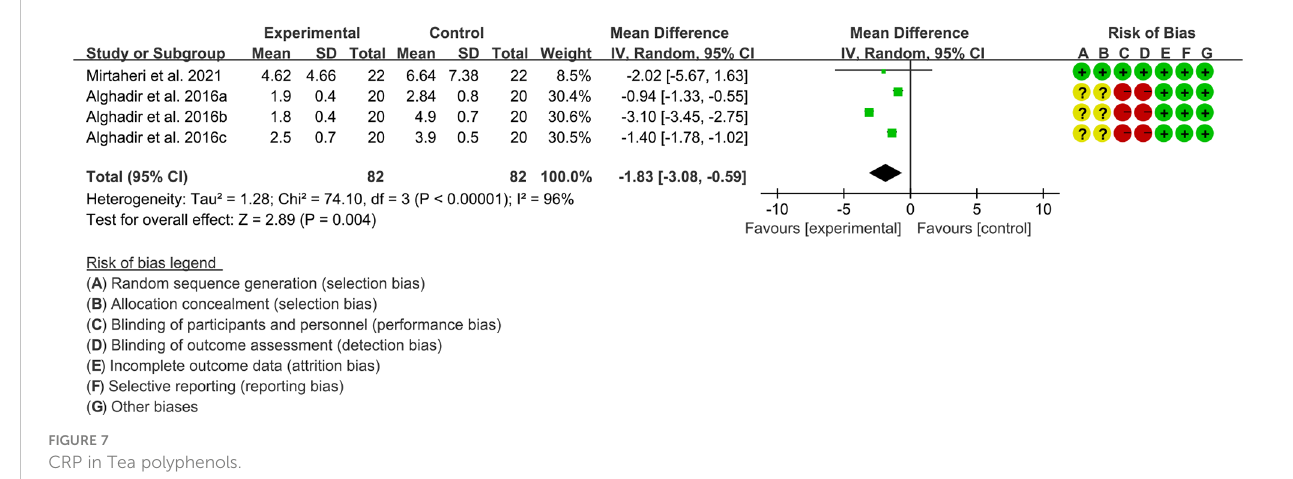
FIGURE 7 CRP in Tea polyphenols.